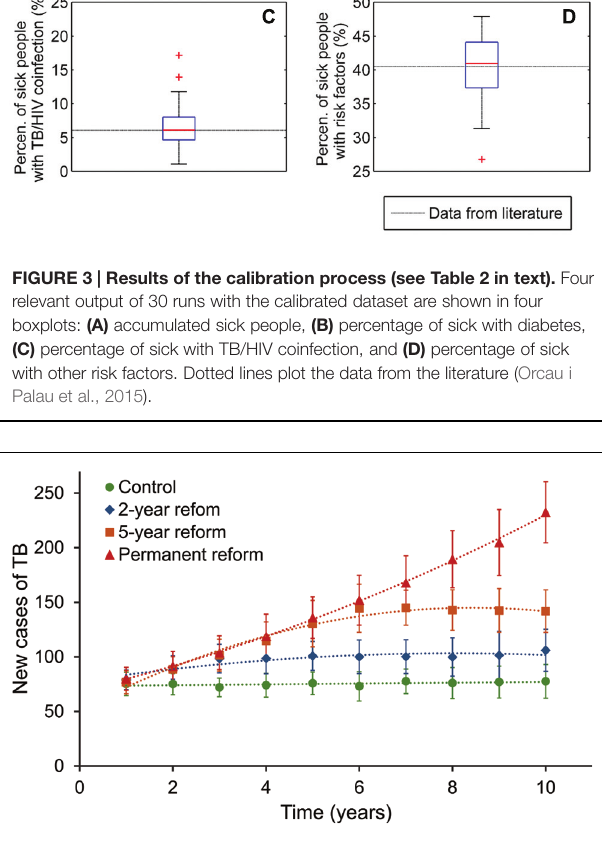
FIGURE 4 | Evolution of annual TB cases over 10 years according to virtual experiments. Four scenarios are considered: current situation (control), in green; a 2-year health care reform, in blue; a 5-year reform, in orange; and a permanent reform, in red. The health care reform would exclude adult undocumented immigrants from the public health system and would consequently increase their diagnosis delay. We assumed the current 33-day period for non-reform cases and a 50-day period for reform